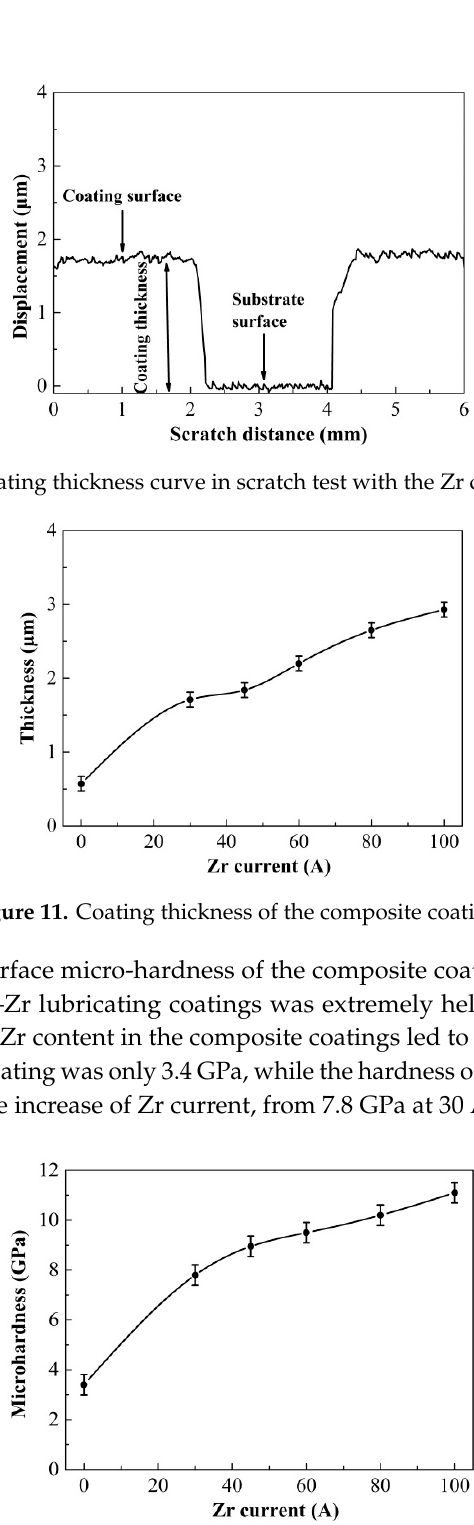
Figure 12. Micro-hardness of the composite coatings.